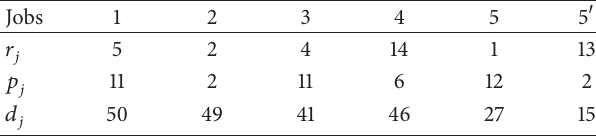
Table 4: Modified instance of Example 2.